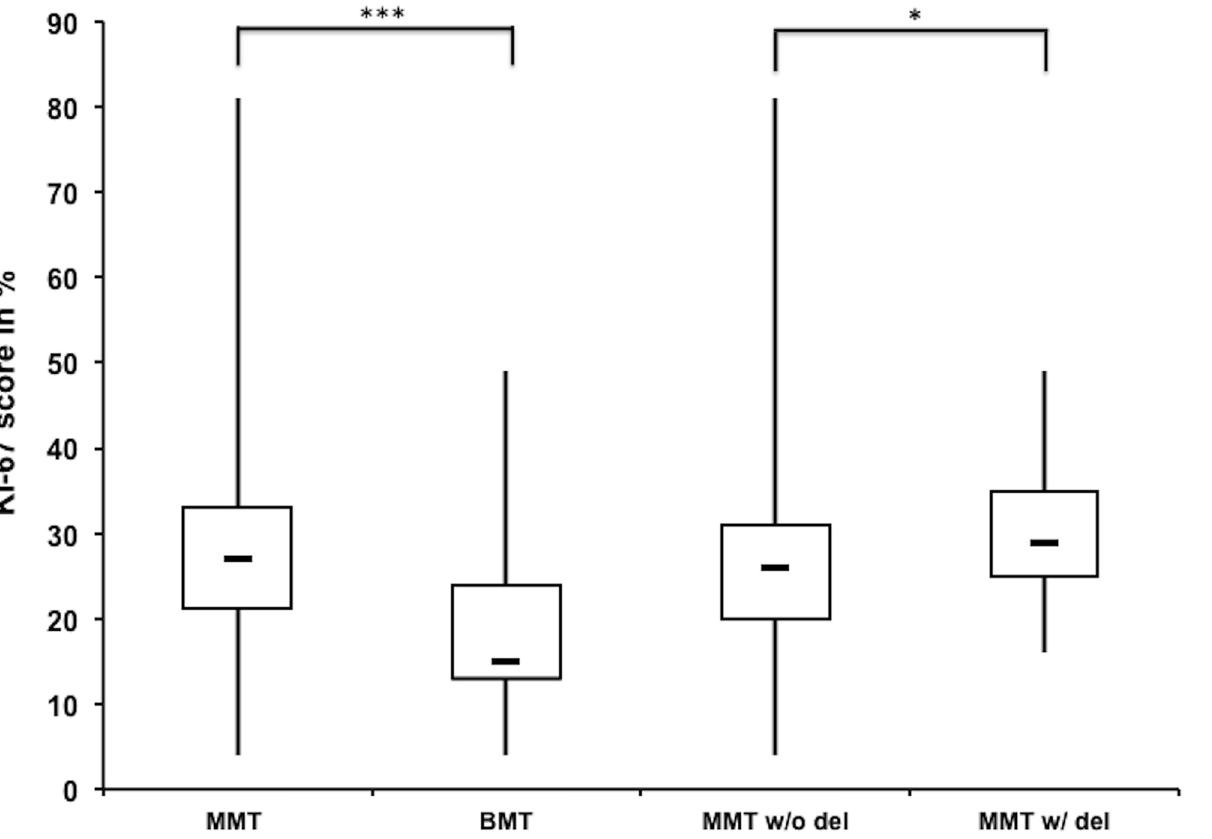
Fig 1. Box plot of Ki-67 scores. Boxplots of Ki-67 score in all malignant mammary tumors (MMT), all benign mammary tumors (BMT) ( *** p < 0.0001), in malignant mammary tumors with (w/) and without (w/o) the PFDN5 deletion and without the carcinoma in benign tumor ( * p < 0.05)